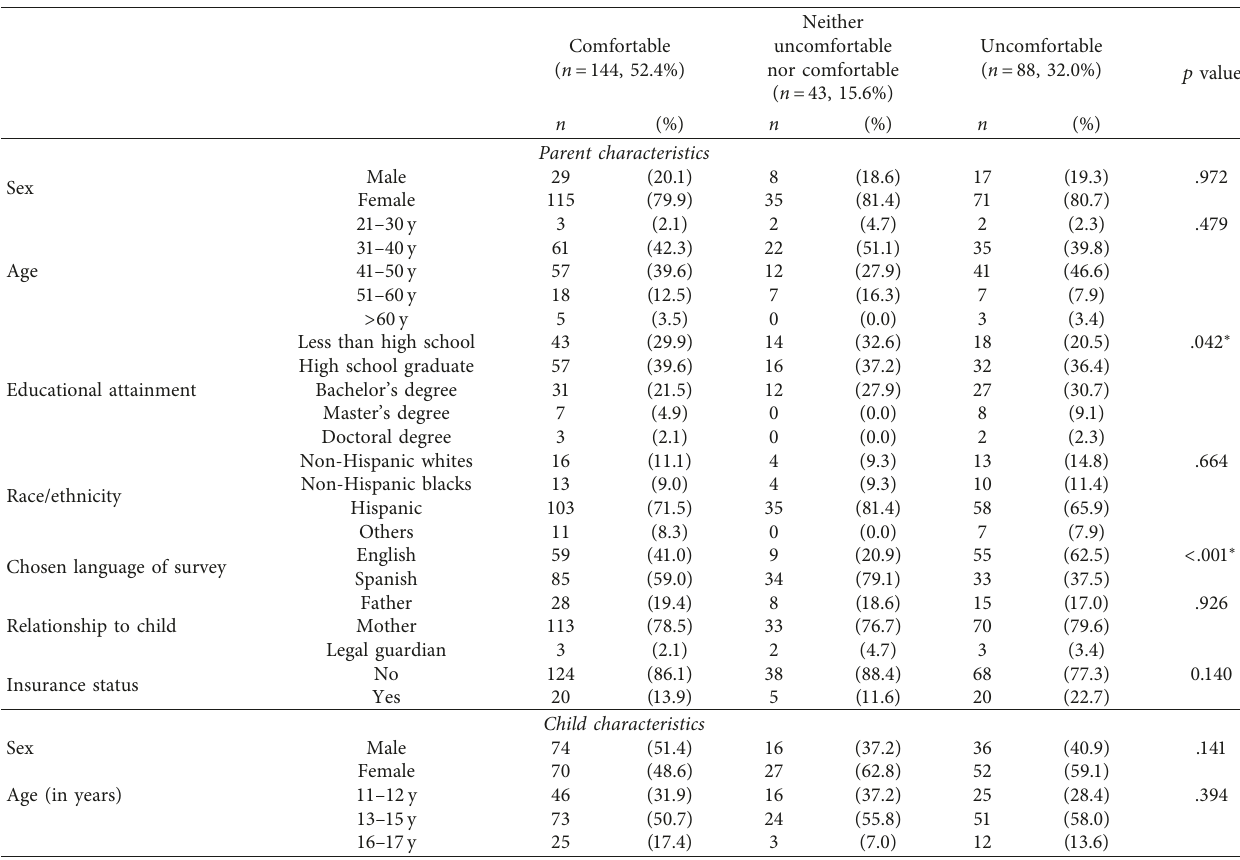
Table 3: Bivariable analysis (Kruskal–Wallis H test): parents’ comfort with orthodontists administering HPV vaccinations to their ad- olescent children by parent and child characteristics ( N �